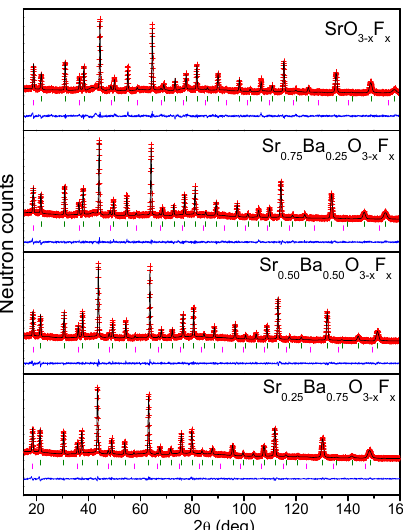
Figure 2. Observed (red crosses), calculated (black line) and difference of (bottom line) NPD Rietveld profiles for Sr 1 − x Ba x FeO 2 F ( x = 0.00, 0.25, 0.50, 0.75) at room temperature (RT), obtained with λ = 1.594 Å. Green lines represent crystallographic Bragg reflections. Pink lines represent magnetic Bragg reflections.